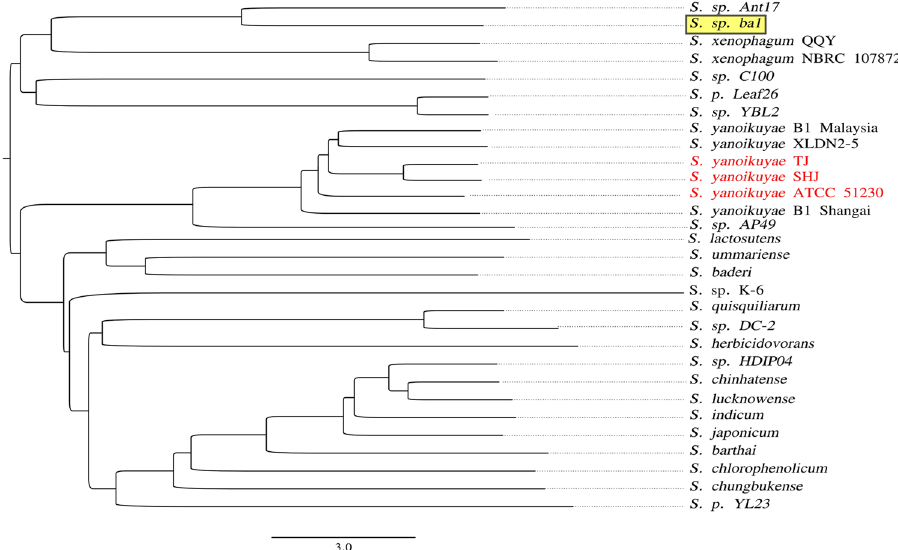
Figure 3. ANIb tree. Phenetic clustering of Sphingobium genome sequences based on ANIb (average nucleotide identity based on BLAST analysis). Sphingobium sp. ba1 and Sphingobium isolates showing a complete and possibly functional Ni 2 + resistance cluster of genes (see Table S3) have been reported with a yellow background and with red characters,